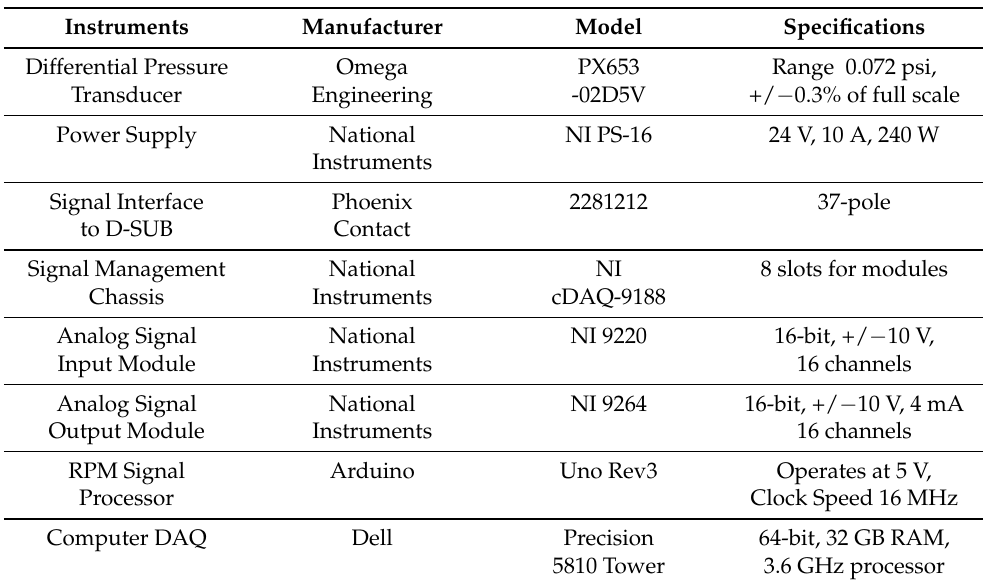
Figure 10. Wind tunnel data acquisition schematic. Table 2. Wind tunnel data acquisition